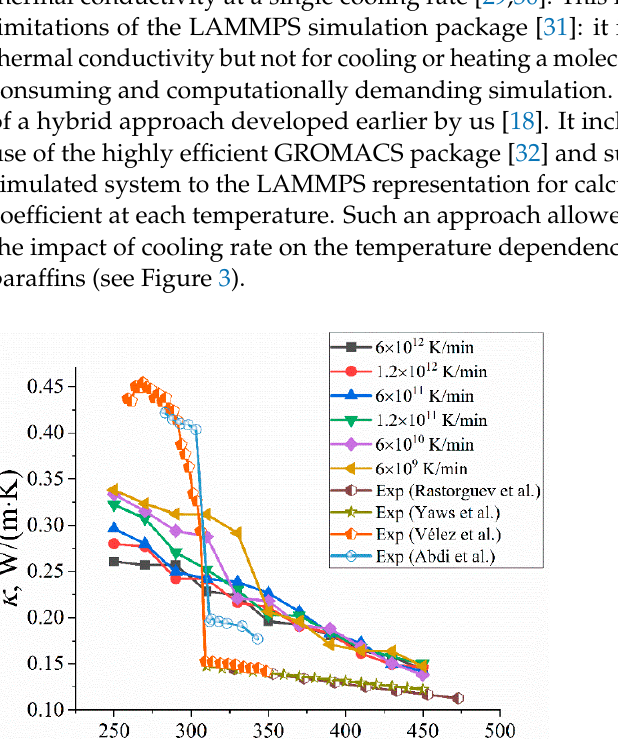
Figure 2. Enthalpy H of n ‐ eicosane samples as a function of temperature T for different cooling rates. The enthalpy was reduced by subtracting the initial linear parts of the H(T) ‐ curves in the low ‐ tem ‐ perature domain. The inset shows the original H(T) ‐ curves.